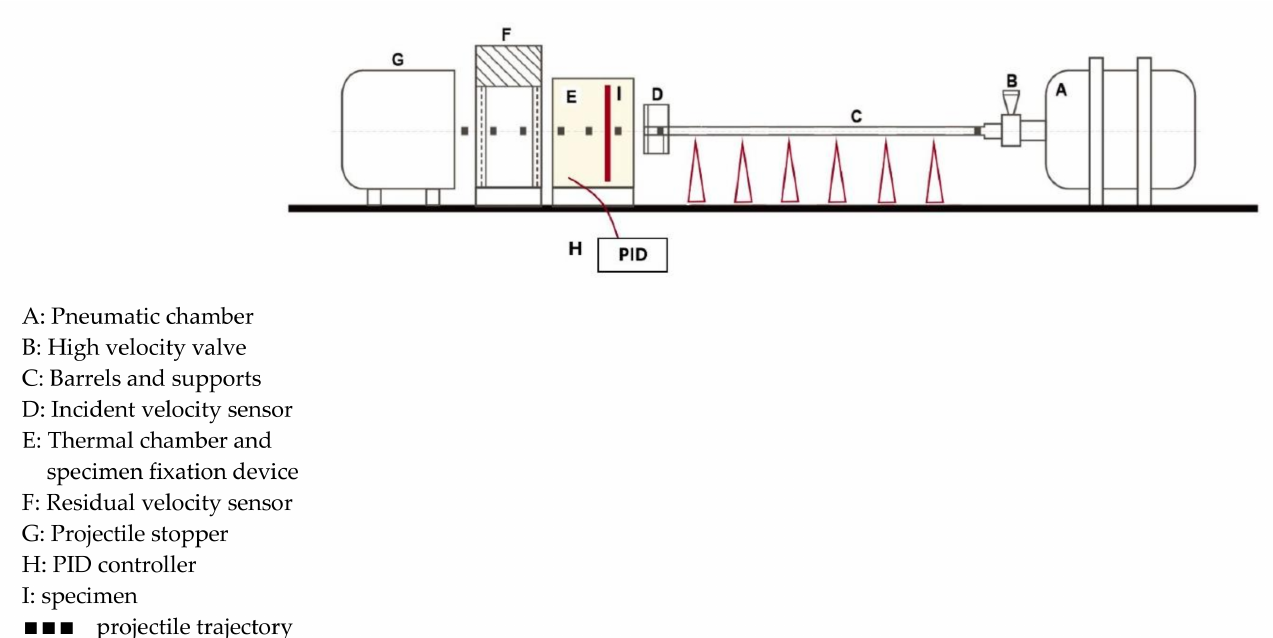
Figure 1. Scheme of gun set-up used for perforation tests at high impact velocities at different temperatures [24].